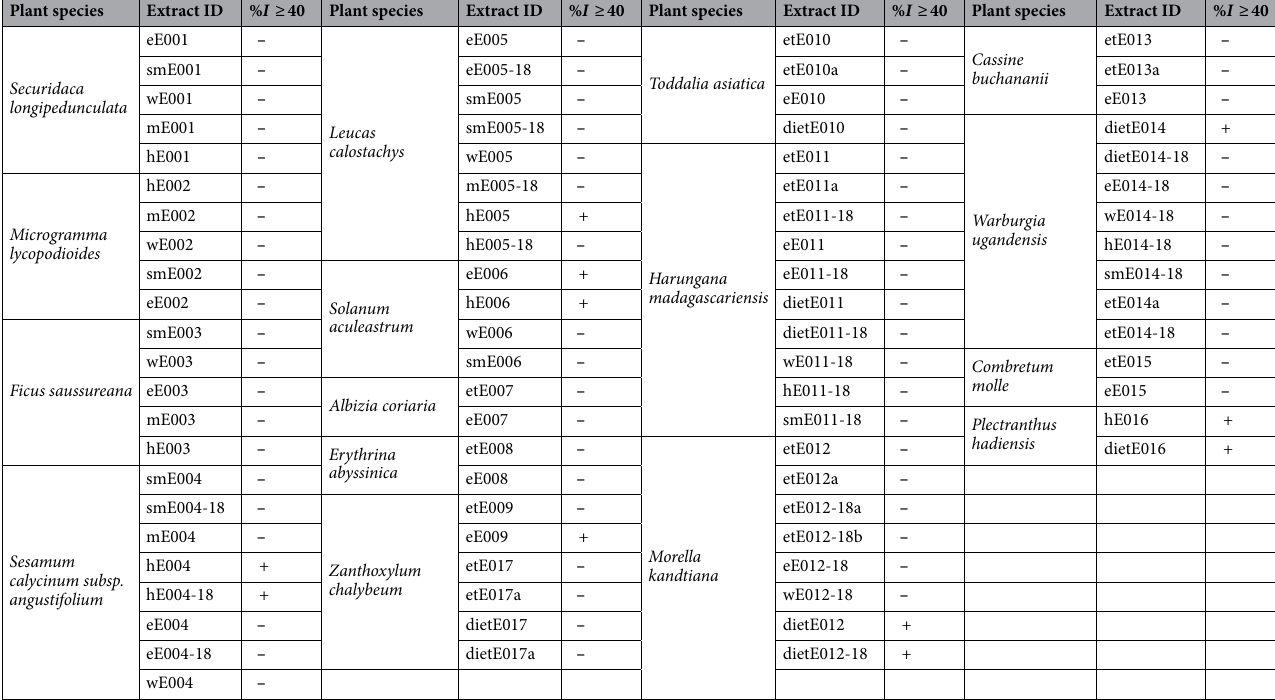
Table 2. Results of quorum-sensing inhibition plant extract library screen on S. aureus agr I reporter strain at 16 μg/mL. –, Quorum-sensing inhibition below 40 percent; + , quorum-sensing inhibition above 40